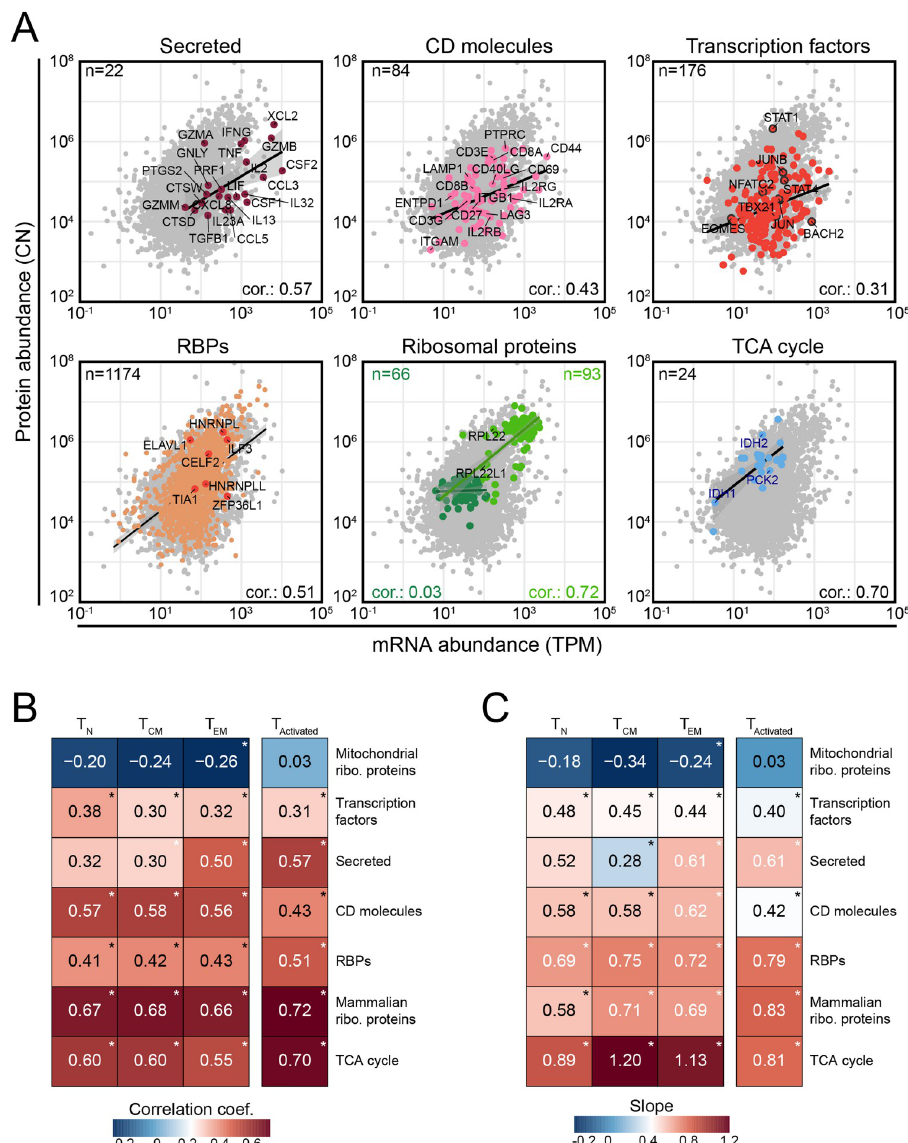
Fig 2. Gene class-specific mRNA and protein abundance. ( A ) Integrated mRNA (TPM) and protein abundance (CN) of secreted proteins, CD molecules, transcription factors, RNA-binding proteins (RBPs), mammalian (light green) and mitochondrial (dark green) ribosomal proteins, and TCA (citric acid) cycle proteins of activated CD8 + T cells (T Activated ). The number of genes per class, the Pearson’s correlation coefficient, and regression line (linear model) were calculated for each class and are indicated in the panels. The correlation was performed independently for mammalian (light green) and mitochondrial (dark green) ribosomal proteins. ( B, C ) Pearson’s correlation coefficient (B) and mRNA-to-protein slope (also known as Beta-coefficient) (C) of the integrated mRNA and protein abundance of gene classes indicated in (A) during T cell differentiation and upon T cell activation. “ � ” indicates correlation and regression with p-value <